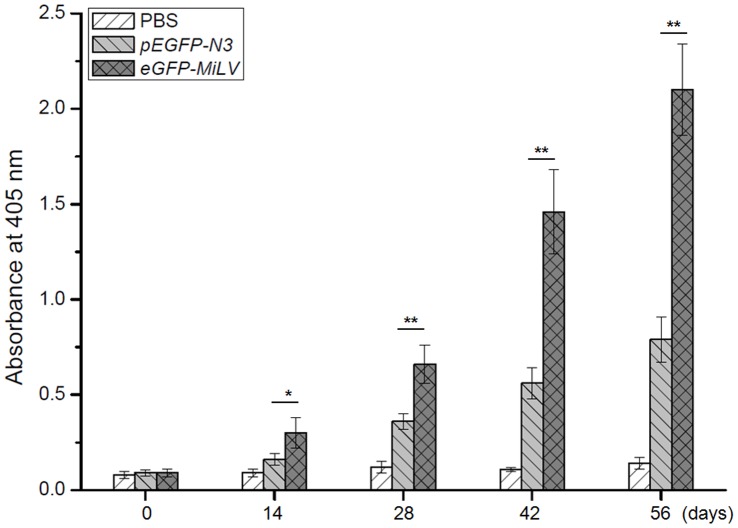
Mean ELISA values of GFP from equal weight (40 µg ) eGFP-MiLV and pEGFP-N3 plasmid immunized mice.The ELISA was performed with mouse sera from individual animals of different vaccination groups. Blood samples were taken and prepared at the indicated time-points before each eGFP-MiLV or pEGFP-N3 plasmid vaccination, and analyzed for reactivity against the GFP (the antigen). * p<0.05; ** p<0.01.